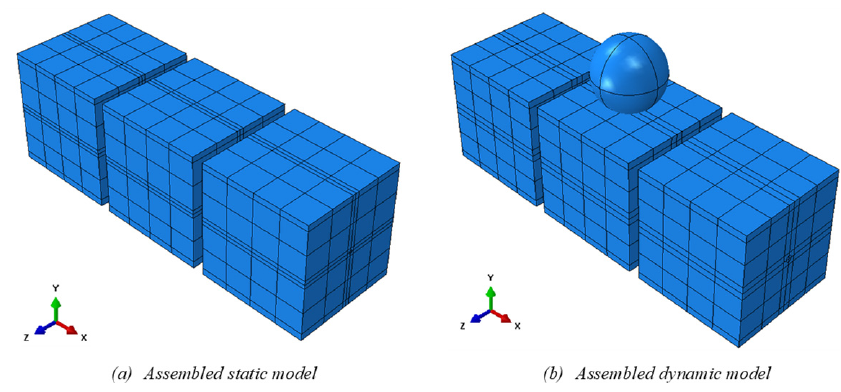
Figure 6. Assembled ABAQUS models (indicated in white).